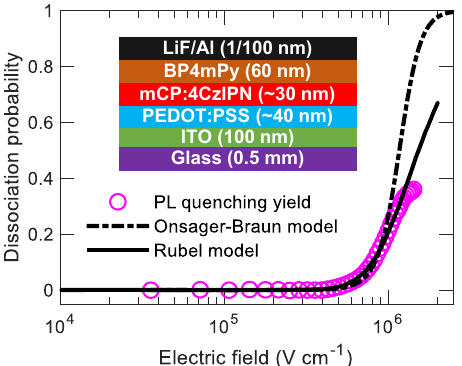
Fig. 1 PL quenching in mCP:4CzIPN OLED under reverse bias. Exciton dissociation probability as a function of the applied electric fi eld. The dash- dot curve and solid line show the modeled quenching behavior as predicted by the Onsager – Braun model with E b = 0.56meV, and Rubel model with E = 0.48 meV, respectively. The inset shows the mCP:4CzIPN OLED b device structure.